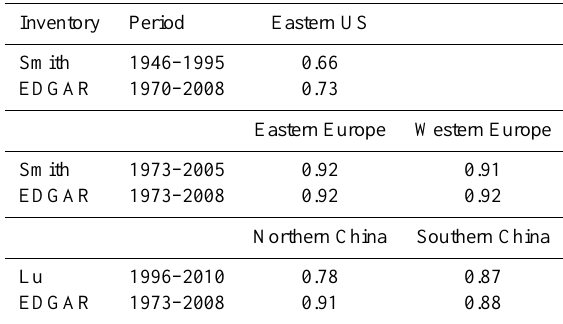
Table 1. Summary of Pearson correlation coefficients ( r ) between annual 1/Vis and SO 2 emissions for five